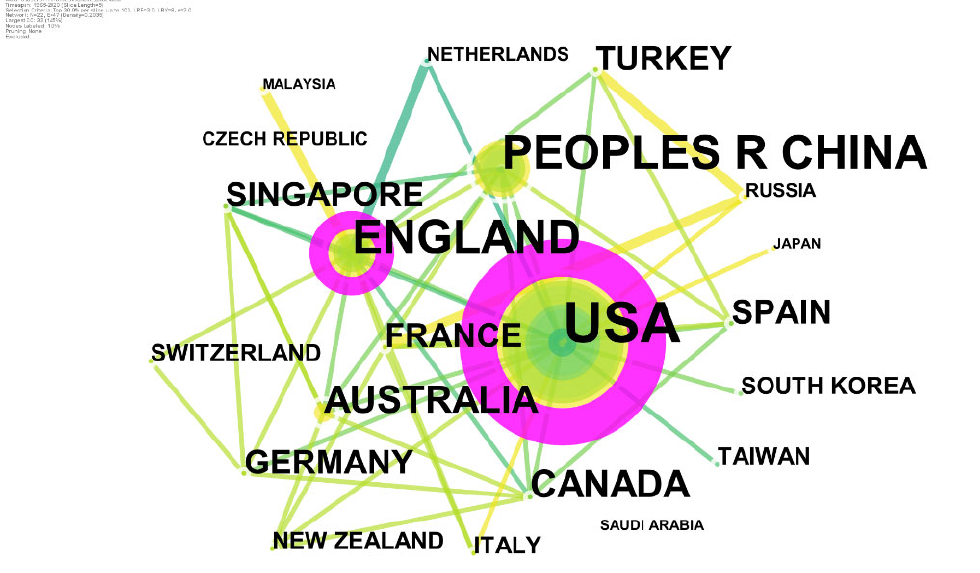
Fig. 2. Country (region) distribution of political risk related papers in